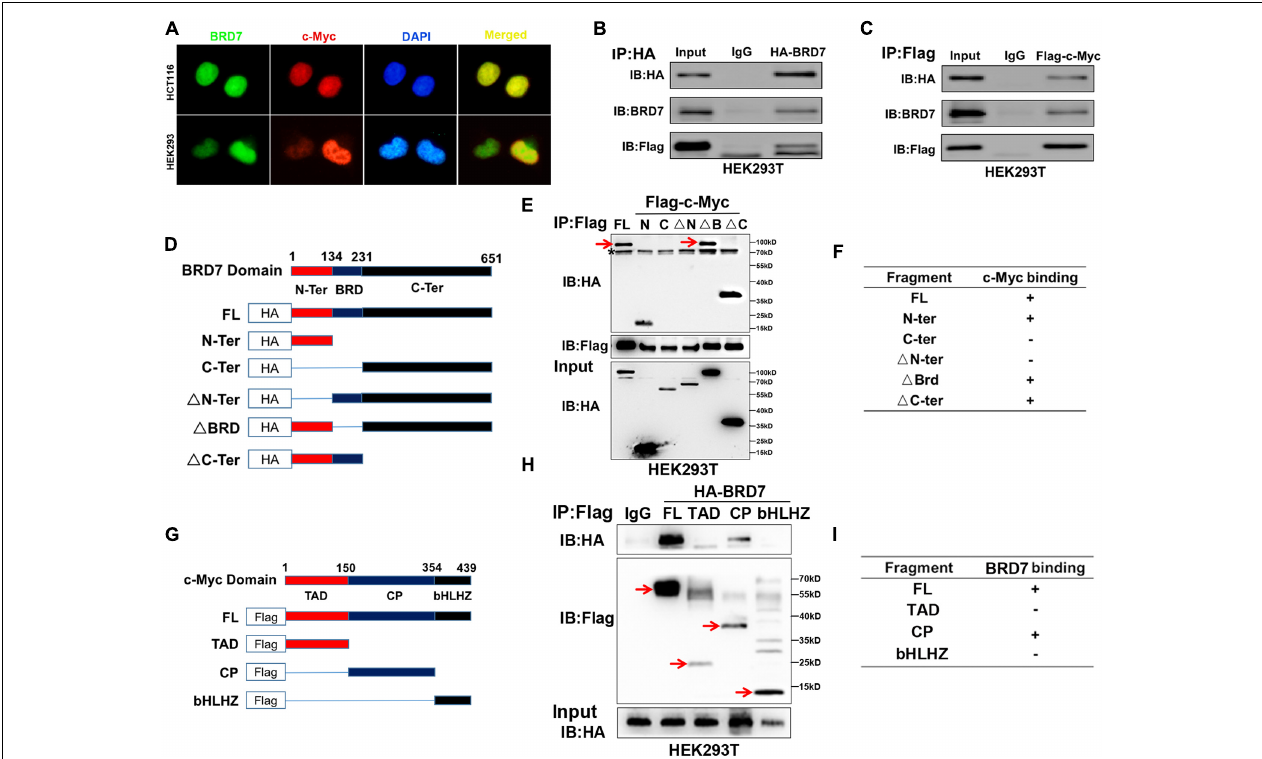
FIGURE 4 | BRD7 interacts with c-Myc in a manner dependent on the N-terminus of BRD7 and the CP-domain of c-Myc. (A) Immunofluorescence assays showed the localization of BRD7 and c-Myc in HCT116 and HEK293 cells. (B,C) Co-immunoprecipitation (Co-IP) confirmed the interaction between BRD7 and c-Myc in HEK293T cells. (D,G) The schematic diagram of different truncated mutants of BRD7 and c-Myc domains. (E,F,H,I) Co-IP assays revealed the structural basis of the interaction between BRD7 and c-Myc. The antibody used for IP detection in (E,H) is anti-Flag antibody, and the antibodies used for IB detection are anti-HA and anti-Flag antibodies, respectively. Of them, Flag was used to tag c-Myc and its mutants, while HA was used to tag BRD7 and its mutants. FL, full length; TAD, transcription activation domain; CP, central portion flanked by TAD and bHLHZ; bHLHZ, basic helix-loop-helix leucine zipper; N-Ter/N, N-terminal; C-Ter/C, C-terminal; (cid:49) N-Ter/ (cid:49) N, N-terminal deletion; (cid:49) BRD, bromodomain deletion; (cid:49) C-Ter/ (cid:49) C, C-terminal deletion. The arrow indicates the destination bands, and * indicates non-specific bands.